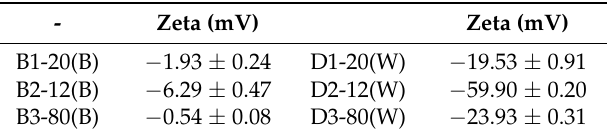
Table 2. Zeta potential of